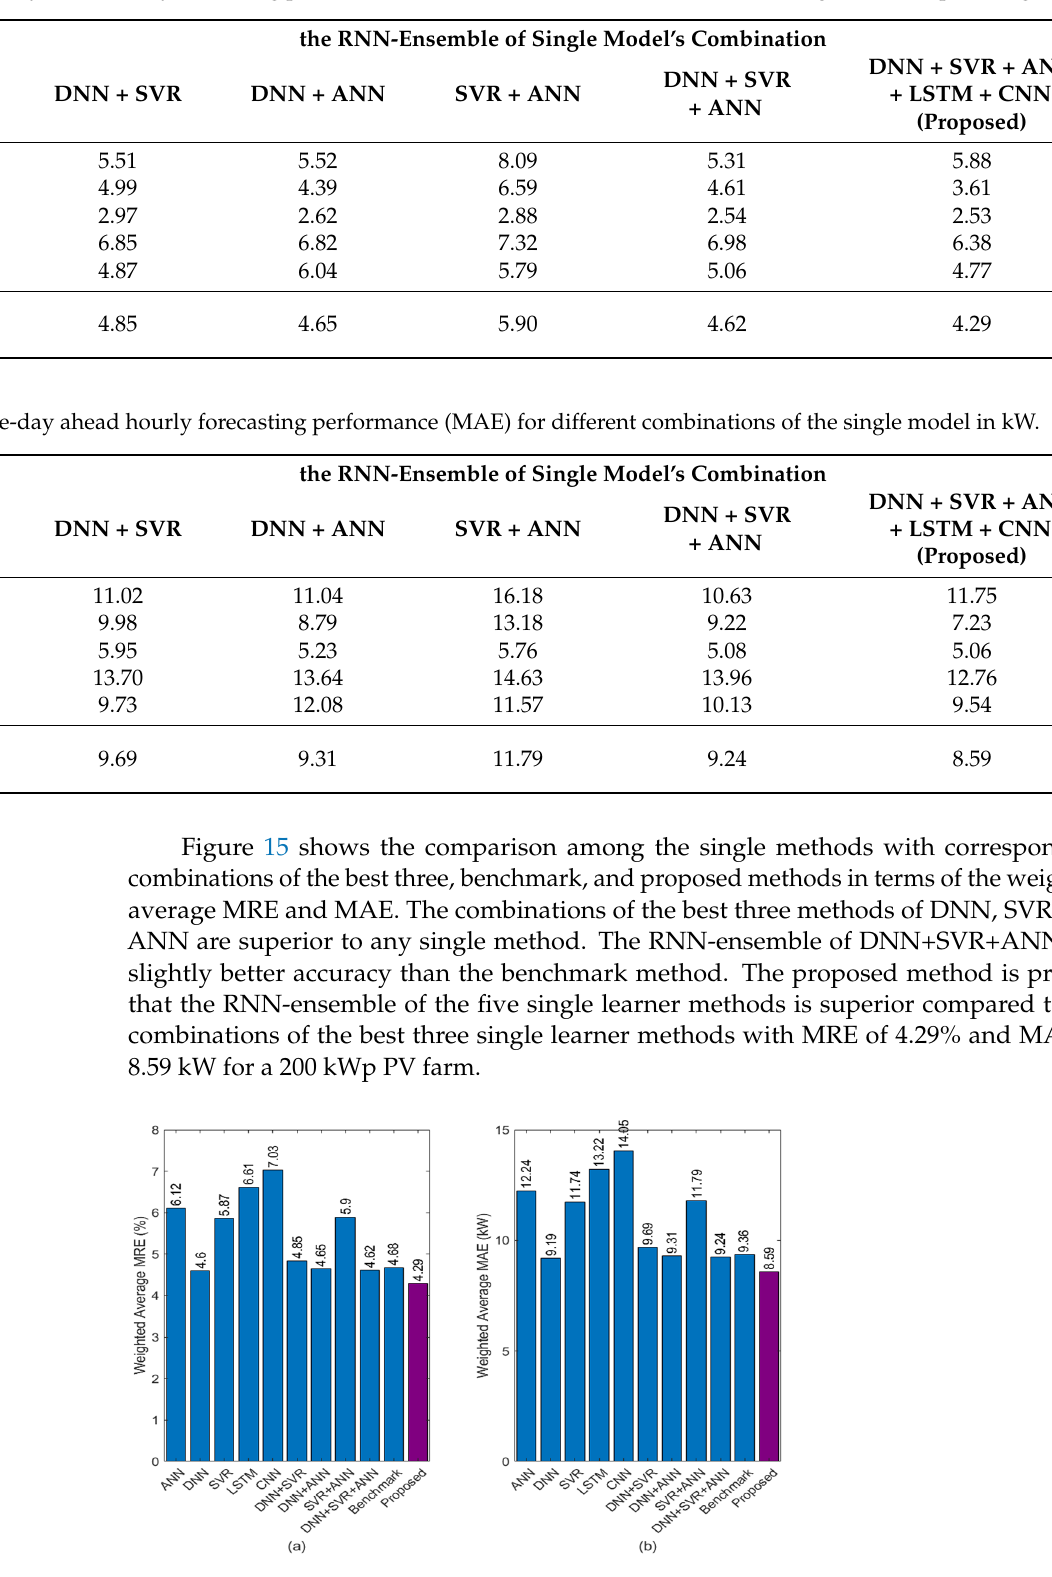
Table 8. Three-day ahead hourly forecasting performance (MRE) for different combinations of the single model in percentage.